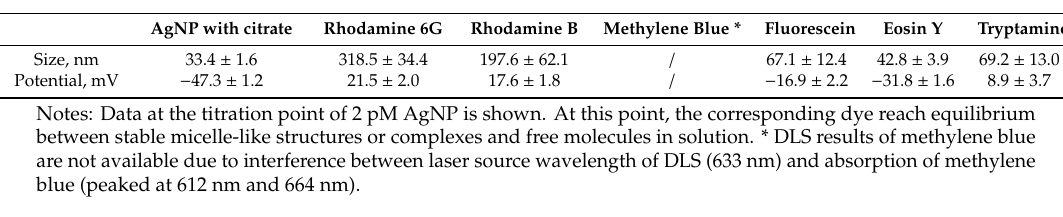
Table 2. Dynamic diameter and zeta-potential of AgNP coated by citrate and in presence of six dye molecules.